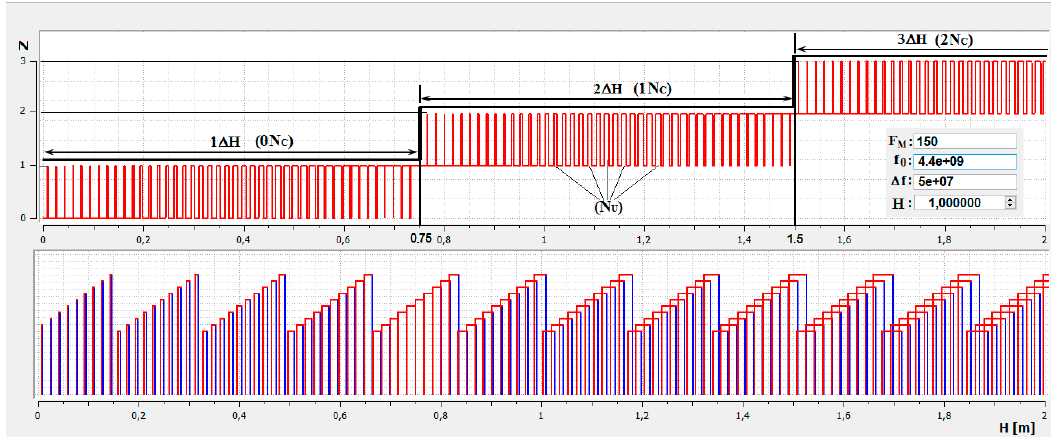
Figure 3. Simulation of the formation of stable and unstable height pulses.